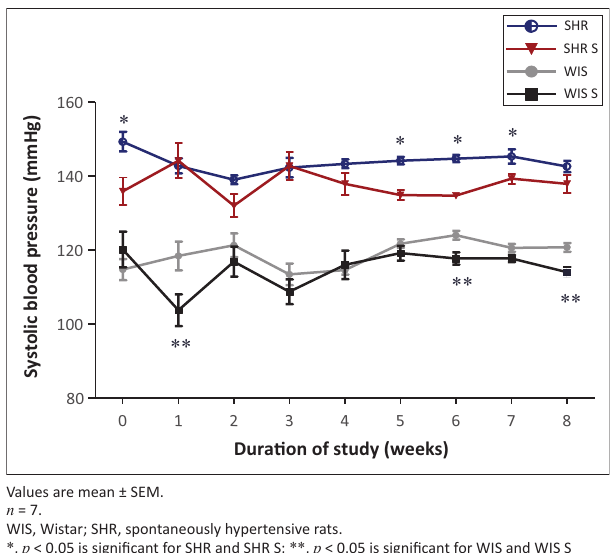
FIGURE 2: The effect of multivitamin-multimineral supplementation on systolic blood pressure in spontaneously hypertensive and Wistar rats.